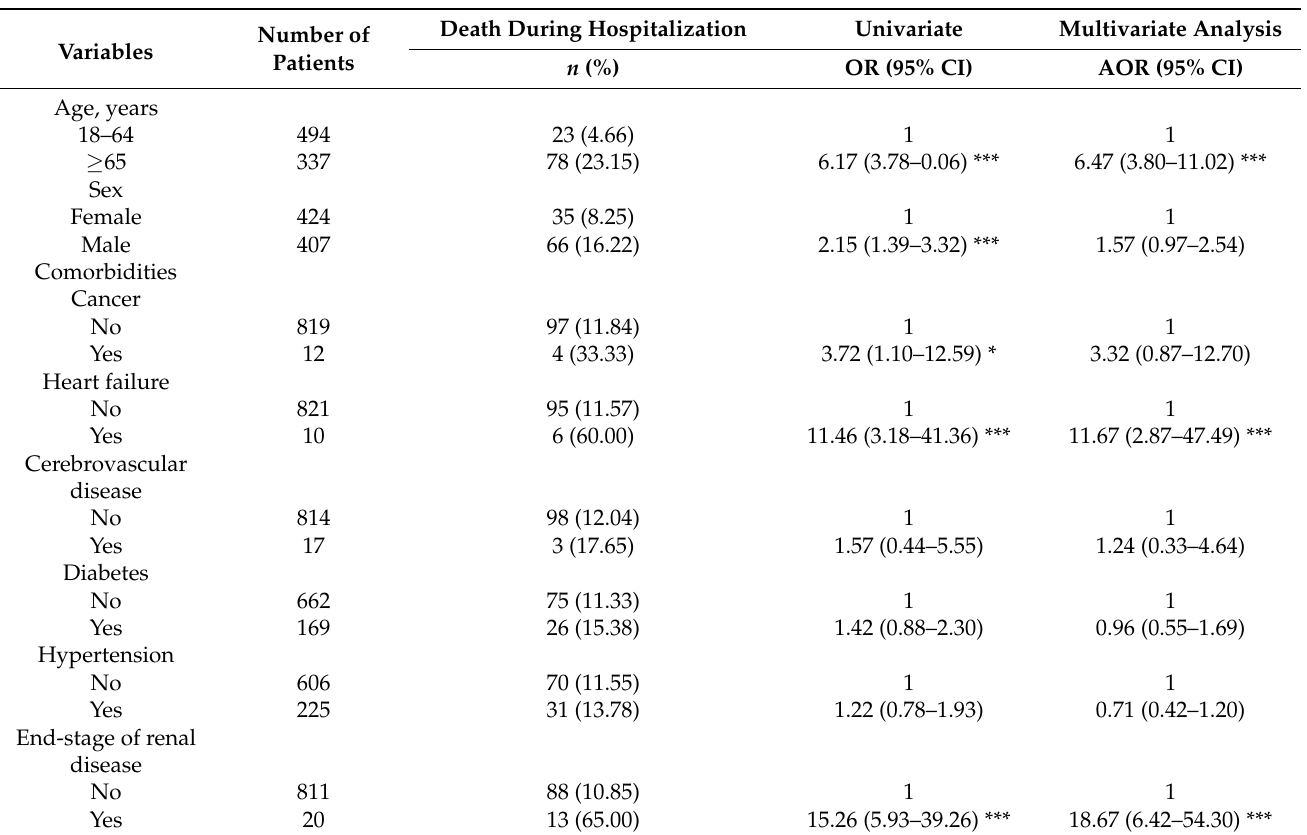
Table 2. Univariate and multivariate analysis of factors associated with mortality among patients with